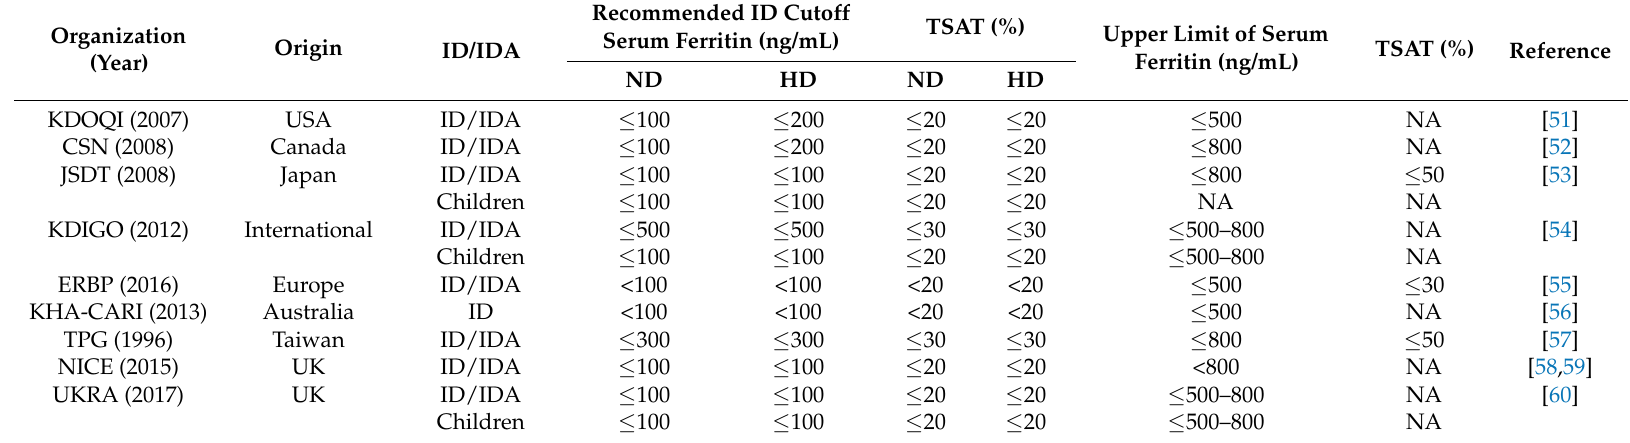
Table 2. International clinical guidelines for diagnosis of IDA and upper limit of serum ferritin and TSAT in CKD